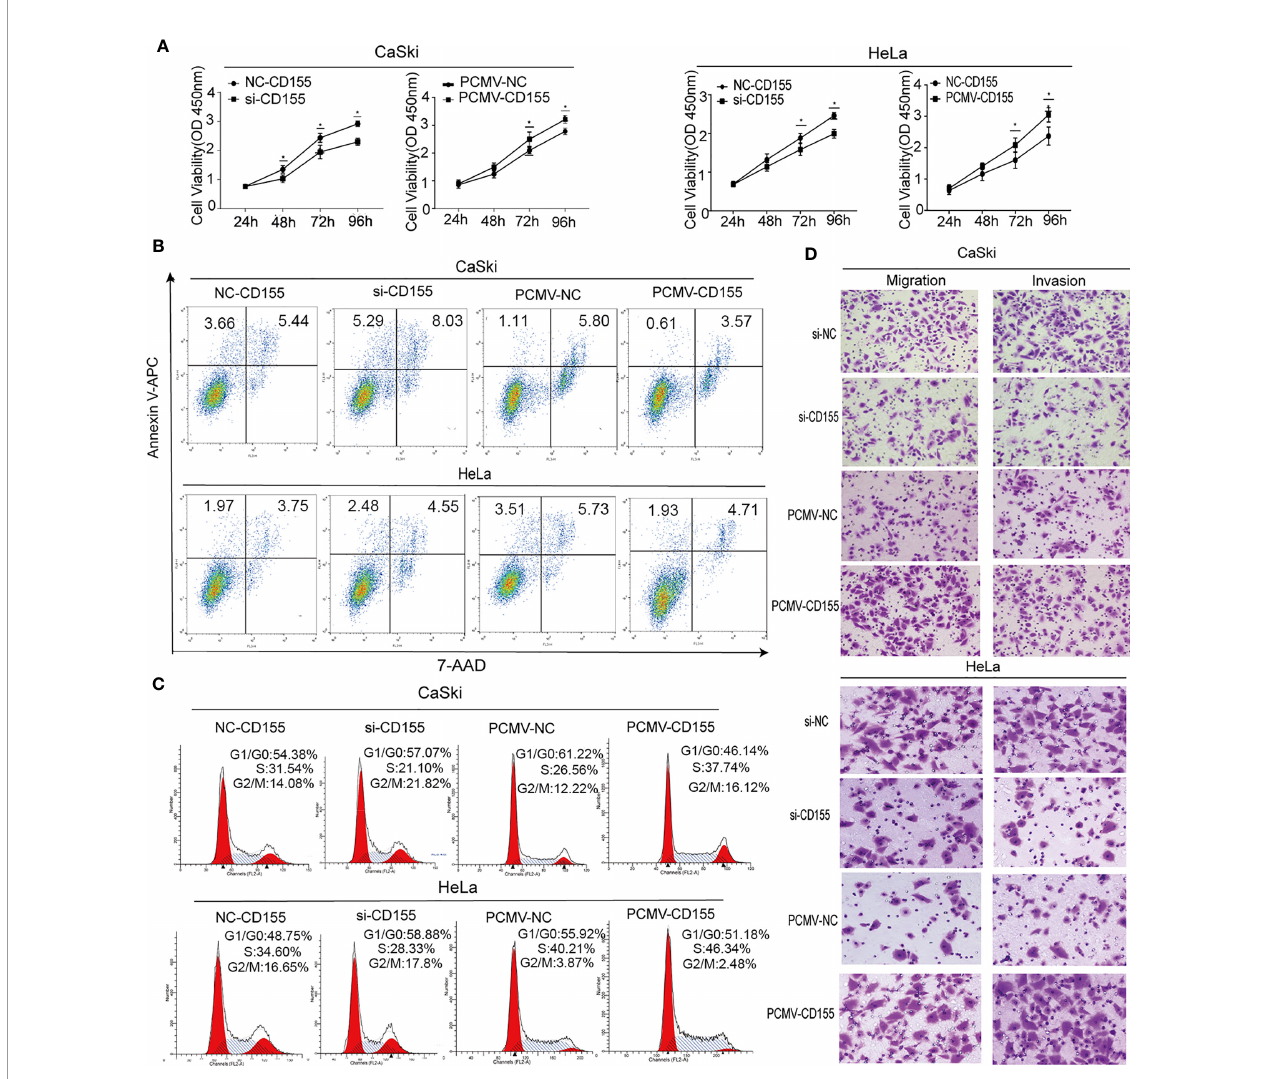
FIGURE 2 | CD155 affects the biological behavior of cervical cancer cells. CaSki and HeLa cells were transfected with NC-CD155, si-CD155, PCMV-NC, and PCMV-CD155. (A) The viability of Hela and CaSki cells was measured by using the CCK8 assay. (B) Apoptosis was detected by fl ow cytometry after staining with Annexin V-APC and 7AAD. (C) Cell cycle analysis by fl ow cytometry. (D) Transwell assays were used to assess the invasion and migration capacity of CaSki and HeLa cells in which CD155 was overexpressed or knocked down. The data are the mean ± SEM of at least three independent experiments. *P <